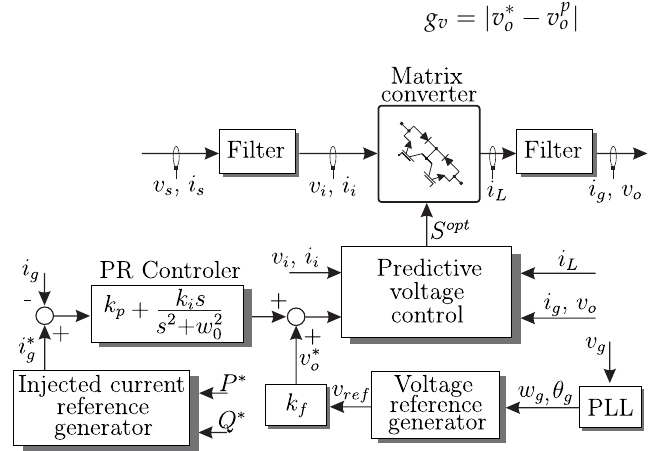
Figure 12. Predictive voltage control block diagram.